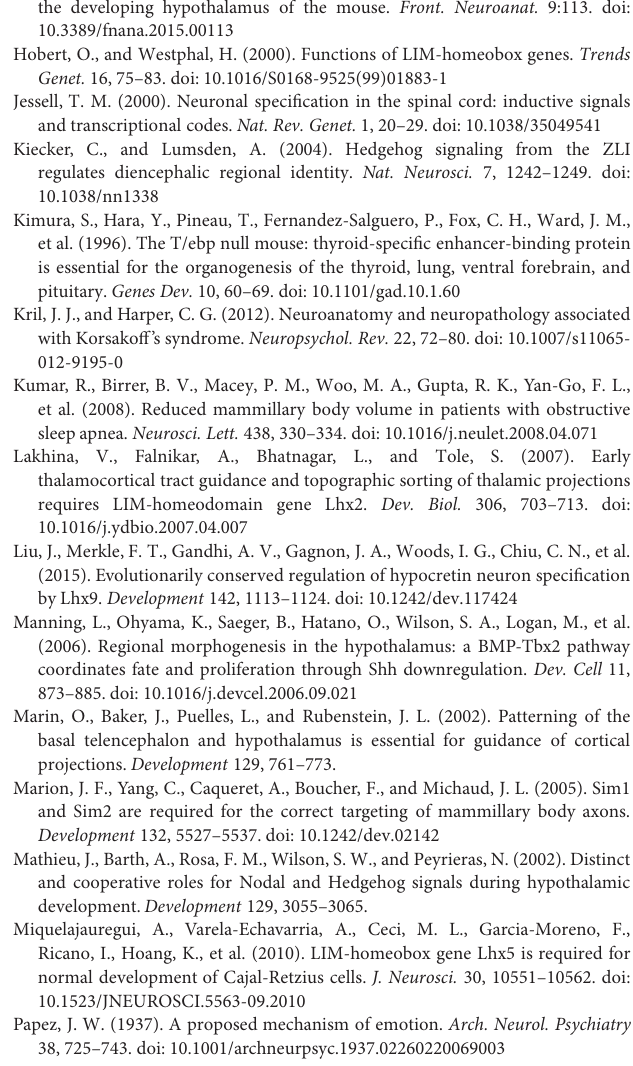
FIGURE S1 | Lhx5 and Lmx1b expression patterns in the posterior hypothalamus appear negatively correlated. Allen Brain Atlas